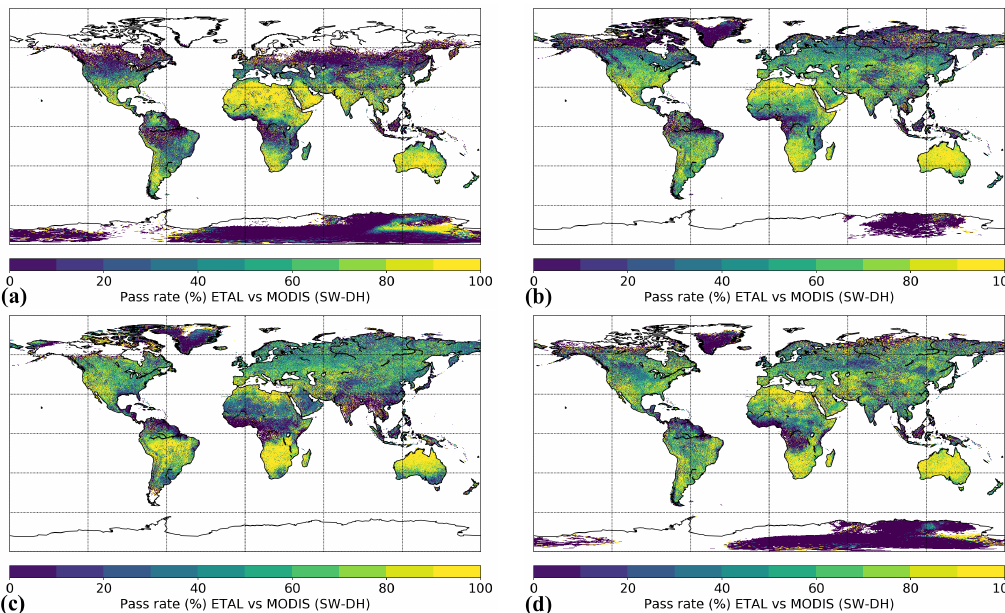
Figure 17. Pass rate for ETAL with respect to MODIS over the period 2015–2018 and per season: ( a ) DJF; ( b ) MAM; ( c ) JJA; and ( d ) SON. Only good-quality surface albedo values (after filtering) are considered. The white color indicates the absence of data (either missing or filtered at the preprocessing